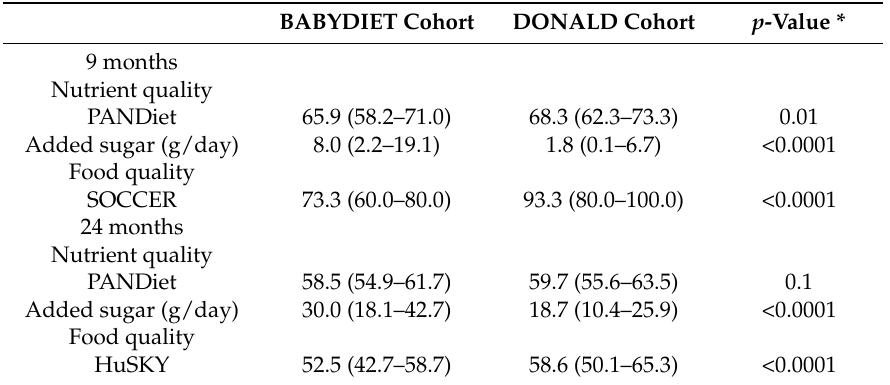
Table 3. Nutrient and food intake quality of children at nine and 24 months of age in the BABYDIET and DONALD cohorts. BABYDIET Cohort DONALD Cohort p -Value *